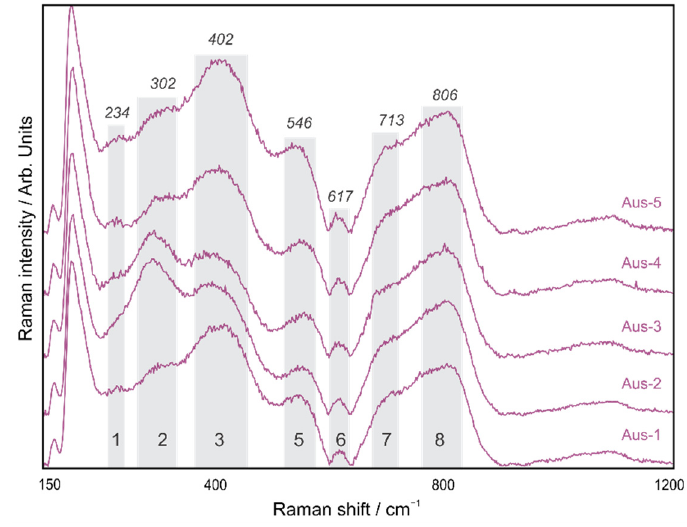
Figure 2. Raman spectra of South Australian pseudorutile showing assigned pseudorutile bands (Table 2).